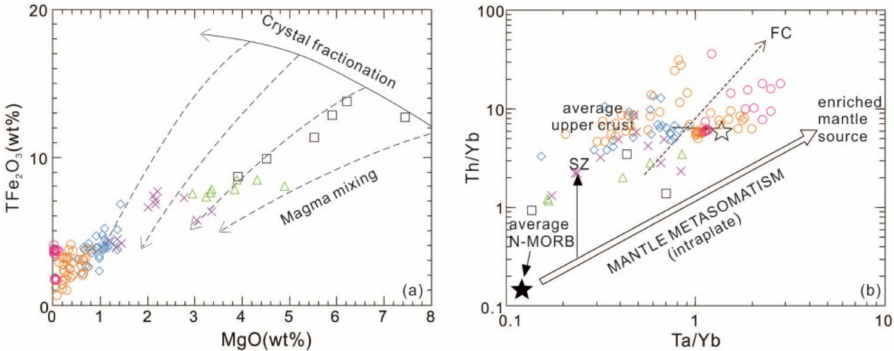
Figure 11. ( a ) TFe 2 O 3 vs. MgO diagrams (after Zorpi et al. [111]); ( b ) Th/Yb vs. Ta/Yb diagrams (after Jahn et al. [112]. The compositions of the MORB (mid-ocean ridge basalt), and upper crusts are after Taylor et al. [113]; the vectors for intra-plate enrichment are based on the data of Pearce et al.